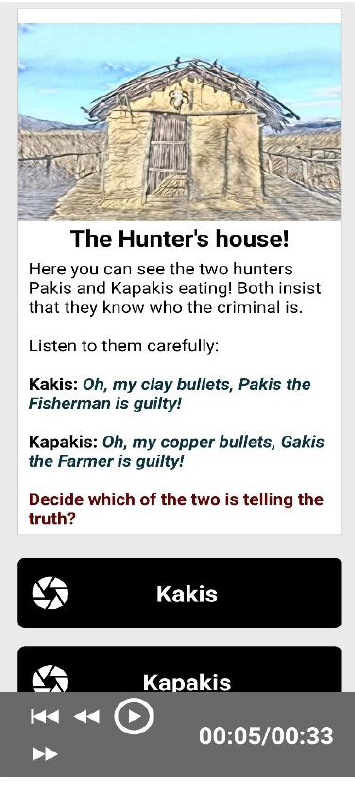
Figure 14. Question for the player.